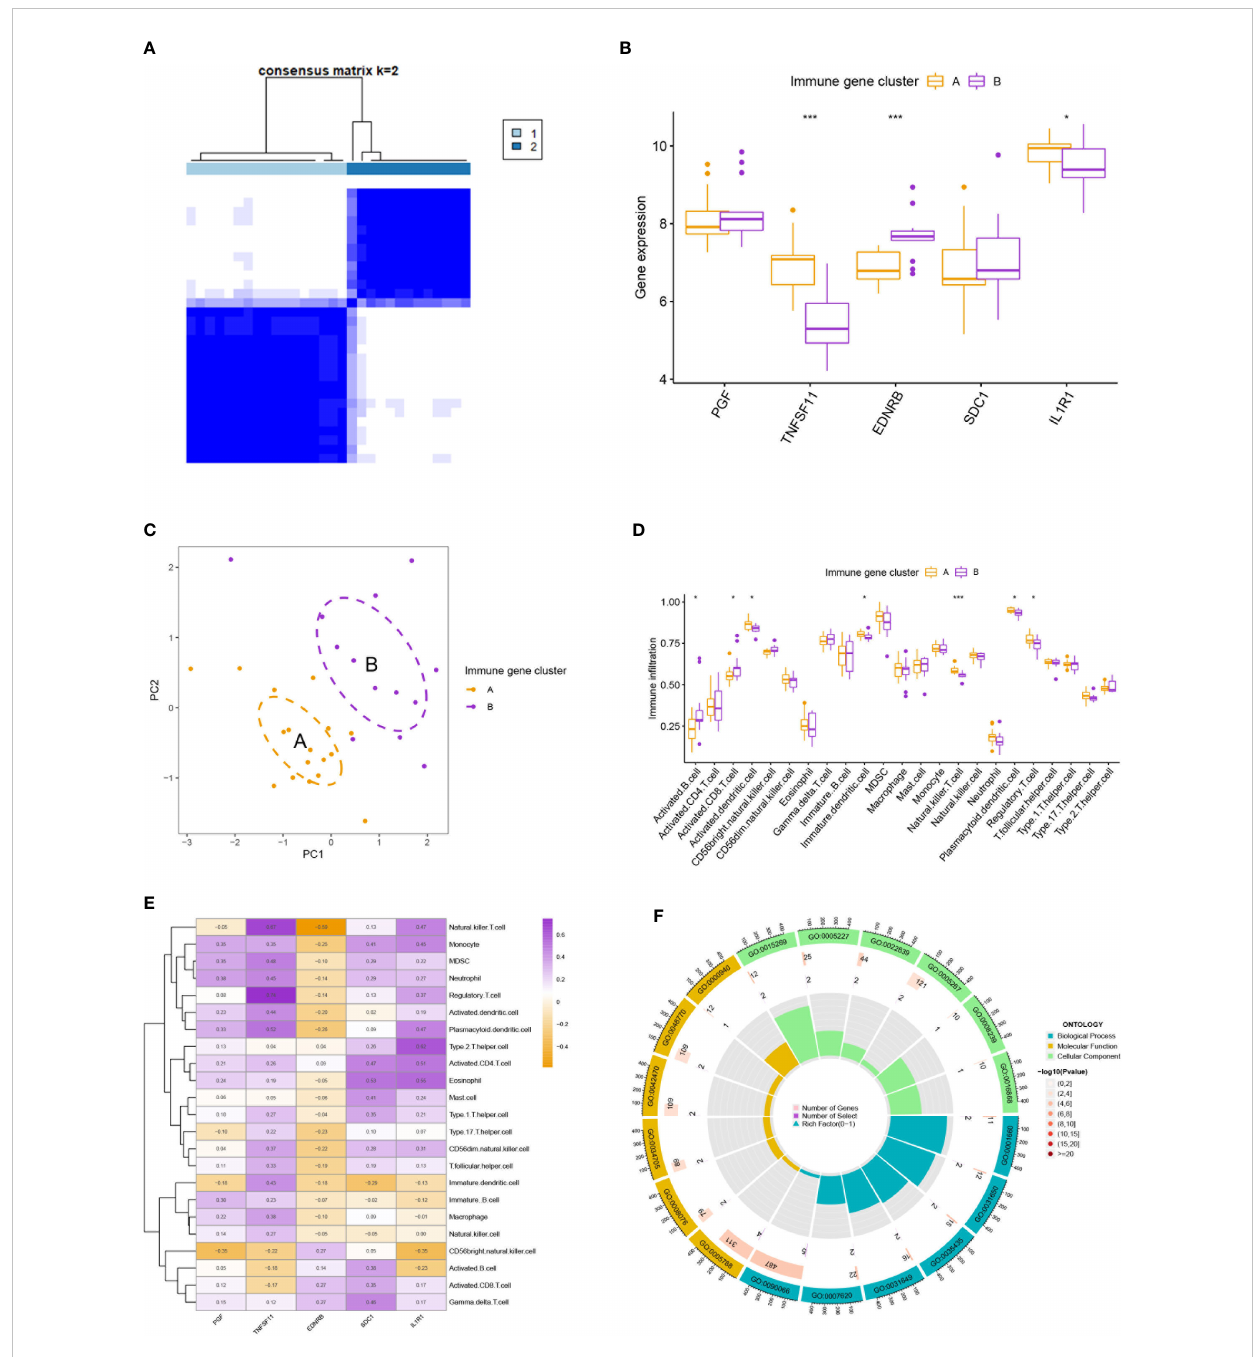
FIGURE 3 Clustering analysis and immune in fi ltration analysis. (A) Clustering analysis strati fi ed patients into two subtypes. (B, C) The two immune subtypes differ in gene expression pattern (B) and geometrical distance (C) . (D) Immune subtype B showed higher in fi ltration of activated B cells and activated T cells than subtype (A) . (E) Correlation analysis between fi ve hub immune genes and immune cells. (F) Gene Ontology enrichment analysis revealed the functional differences between the two immune subtypes. * means P < 0.05, *** means P <